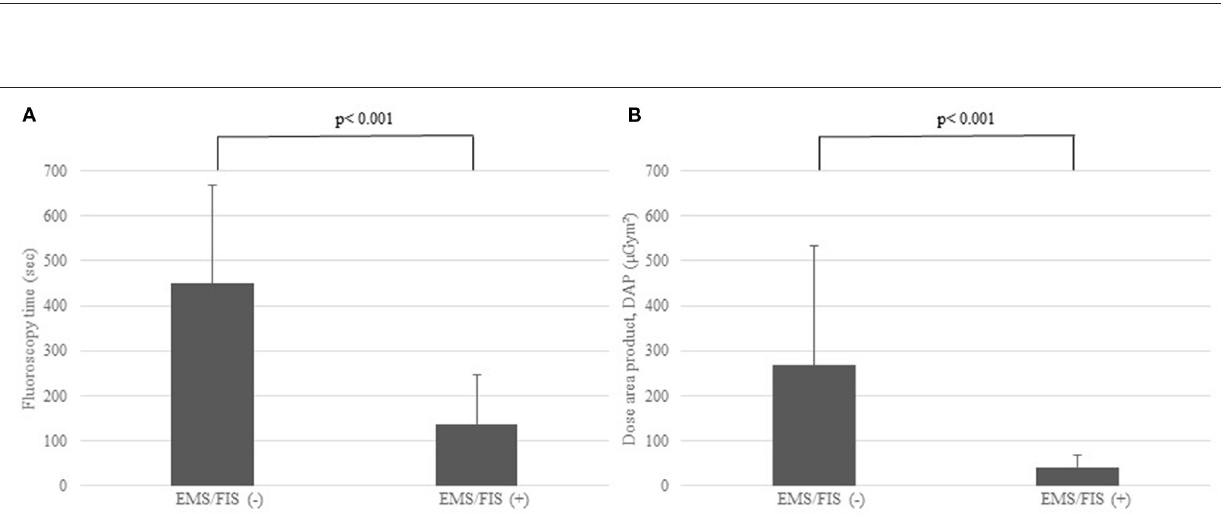
Frontiers in Cardiovascular Medicine |